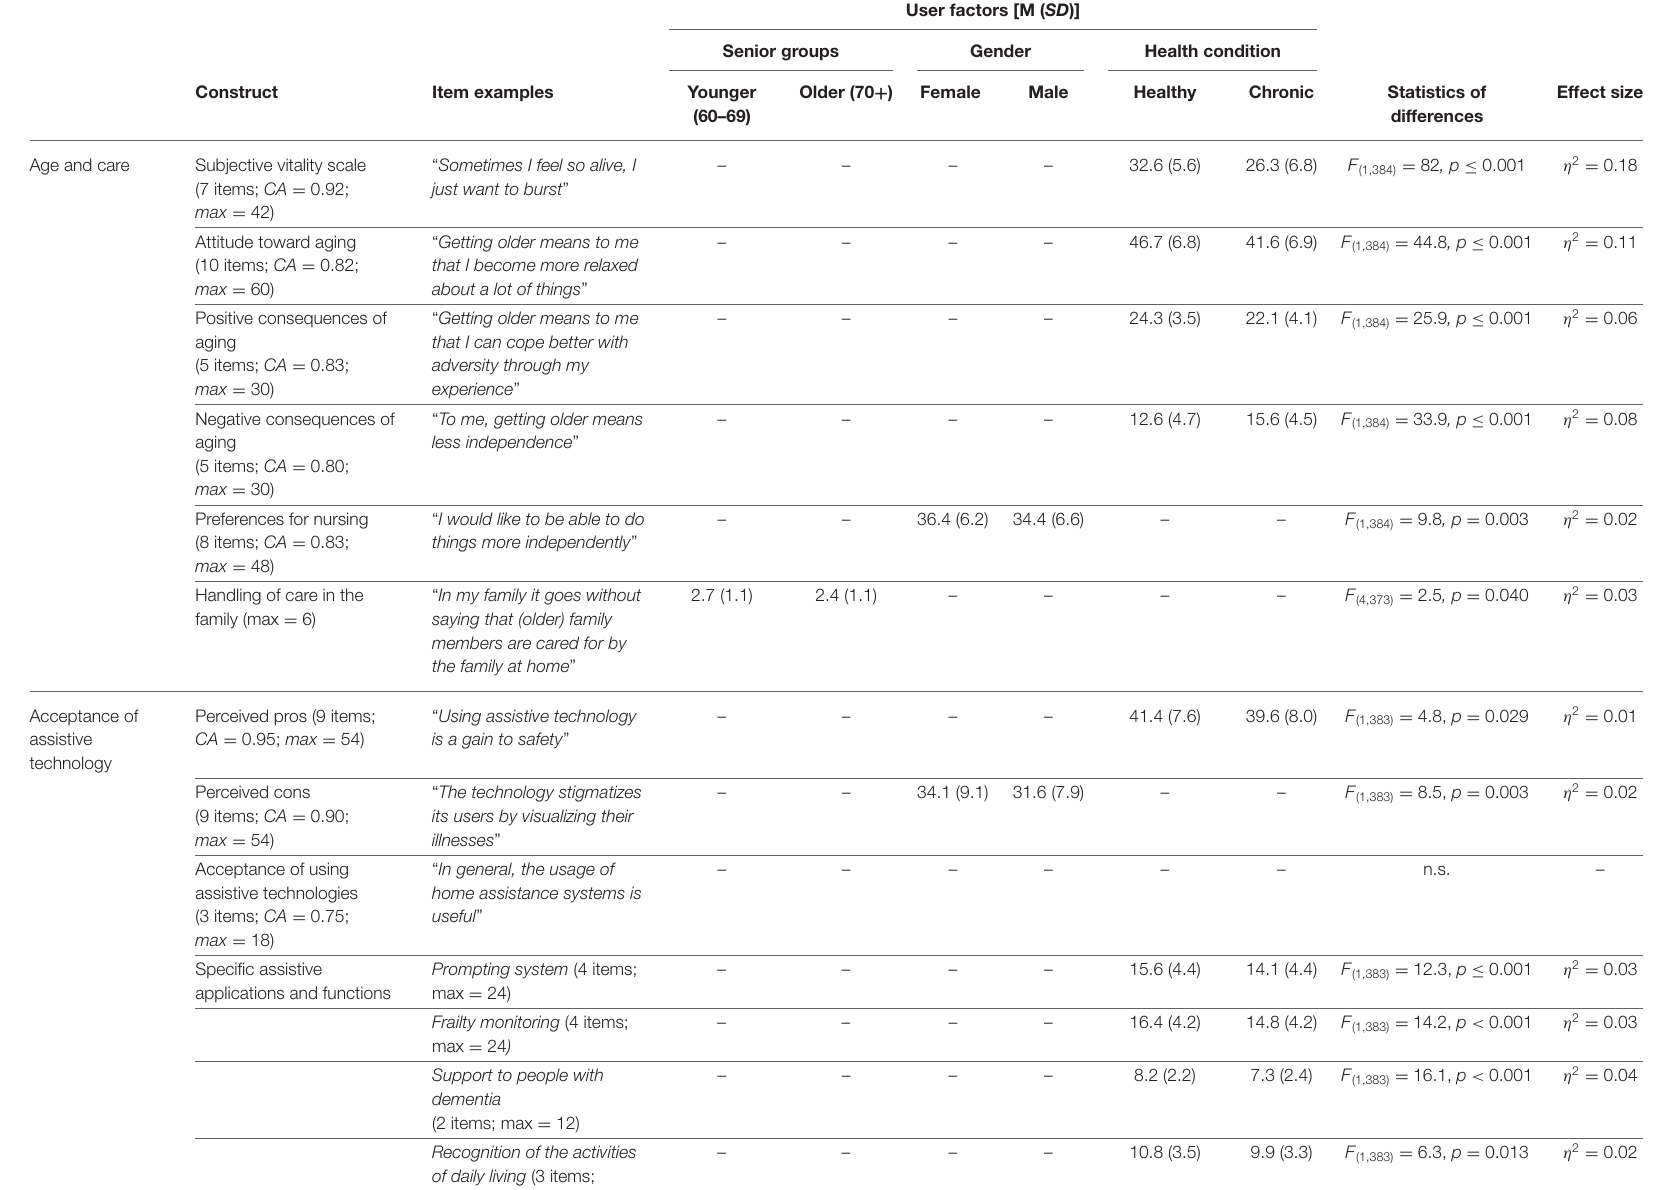
TABLE 1 | Statistical results for the significant effects of the user factors on the perceptions of aging, nursing care, and acceptance of assistive technologies ( N = 384); CA = Cronbach’s